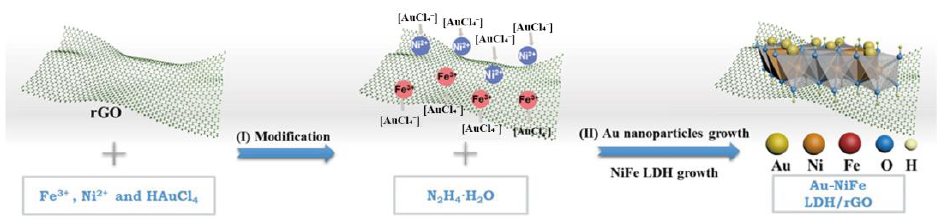
Figure 4. Representation of the fabrication process of Au-NiFe LDH/rGO nanocomposite. Reprinted with permission from [60] .Copyright 2020 Elsevier B.V.